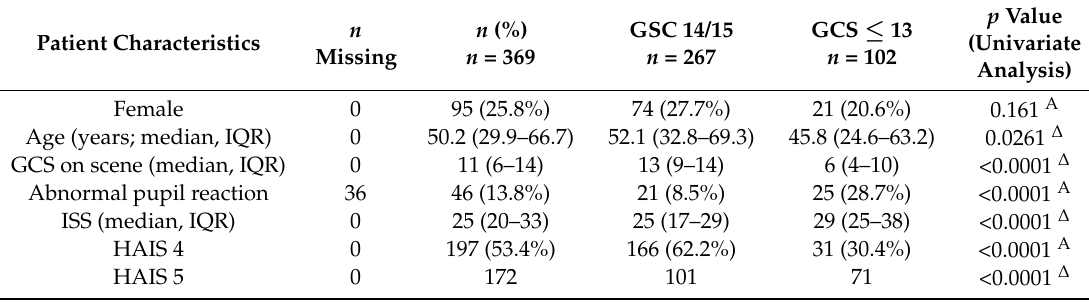
Table 3. Description of surviving patients with regained consciousness (Glasgow Coma Scale 14 and 15) and impaired consciousness (Glasgow Coma Scale ≤ 13) at 14